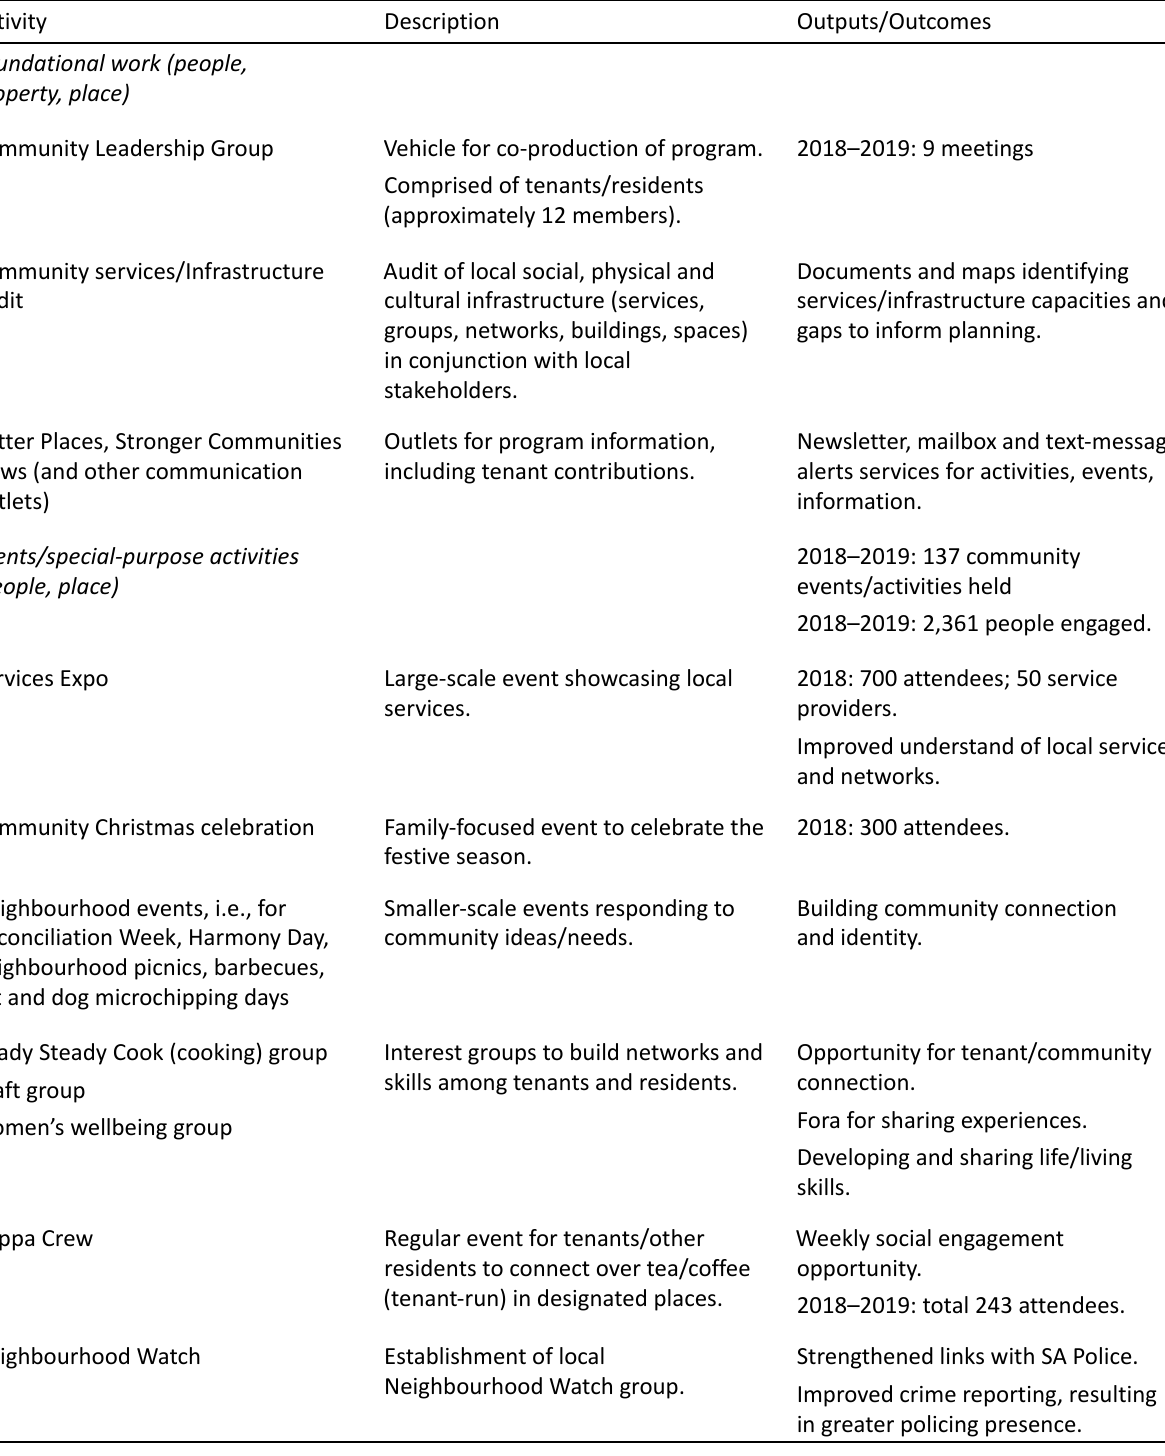
Table 1. Community development activities, northern Adelaide Better Places, Stronger Communities